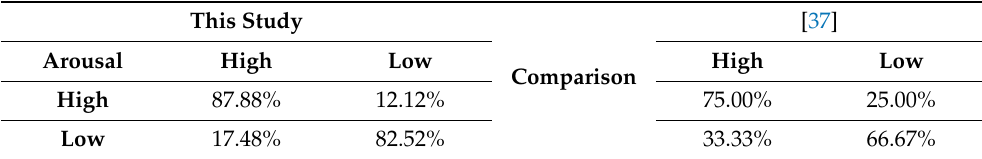
Table 11. Arousal classification comparison of proposed approach versus existing results.